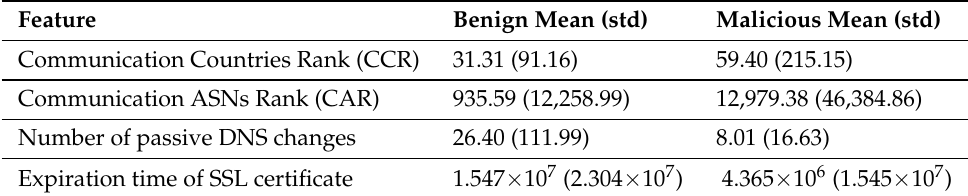
Table 3. Novel features and statistical